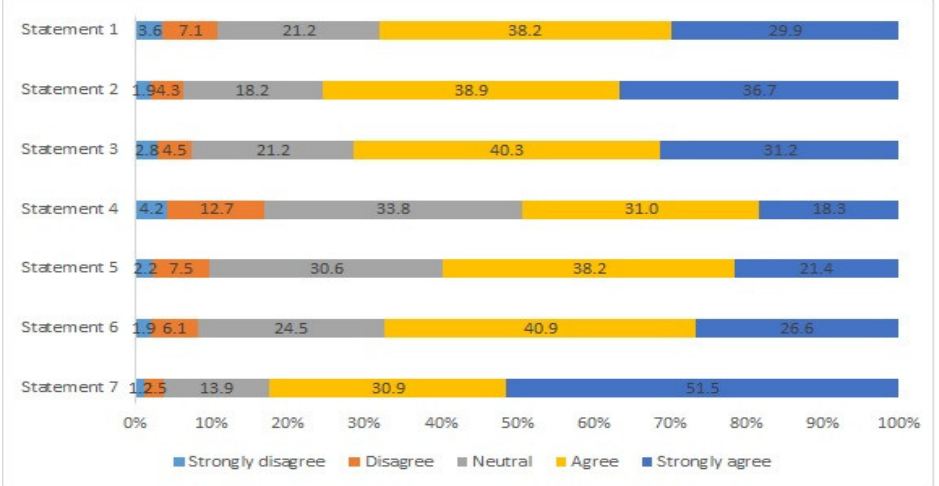
Table 2. Simple regression results.